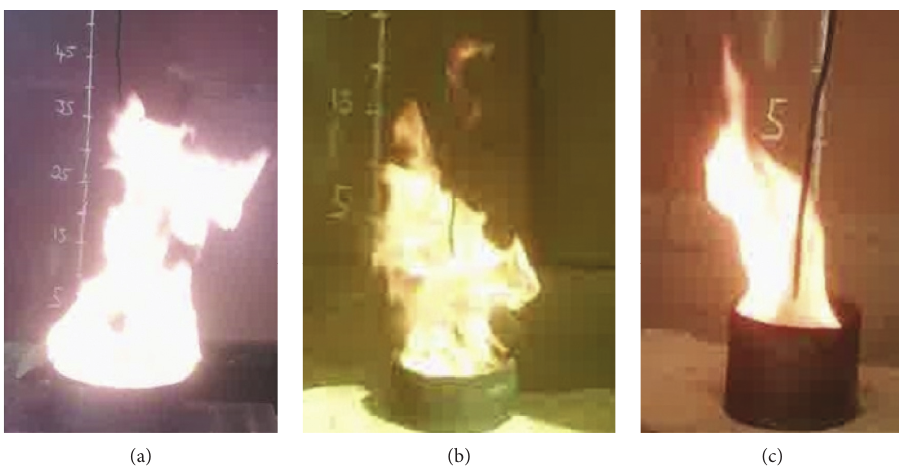
Figure 3: Images of flame during free fires: (a) source 1, (b) source 3, and (c) source 5.